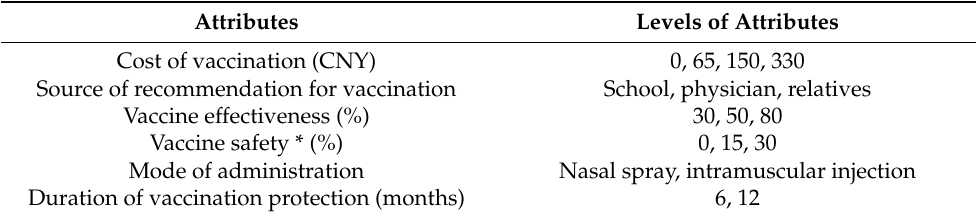
Table 1. Attributes and levels included in the DCE